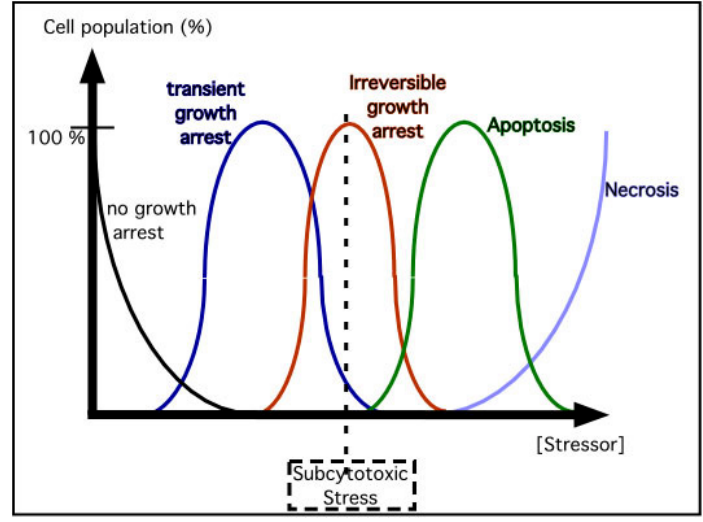
FIGURE 1. When a cell population of a given cell type is exposed to stress at subcytotoxic level (vertical dotted line), a gross majority of cells become irreversibly growth arrested and prematurely “senescent” while a minority of other cells might eventually resume